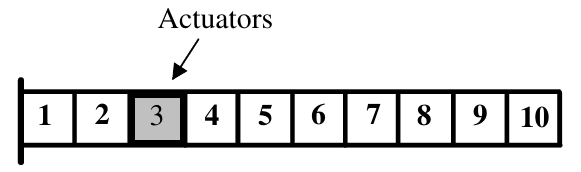
Fig 2. Illustration of an aluminum plate with PZT pairs for position 3